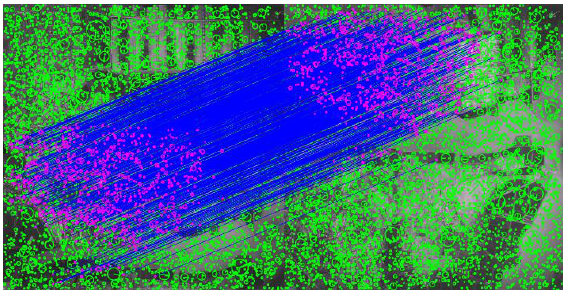
Figure 12. RANSAC result of Case 1.